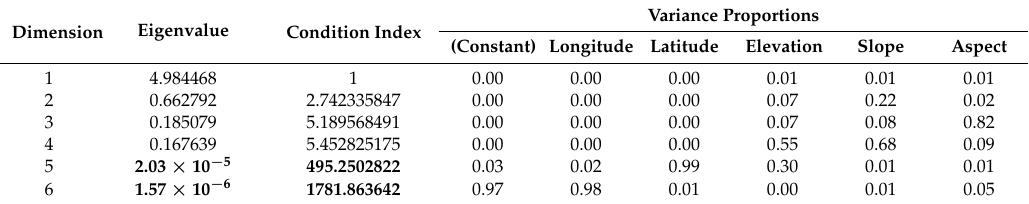
Table 3. Collinearity Diagnosis of the Multiple Linear Regression (MLR)